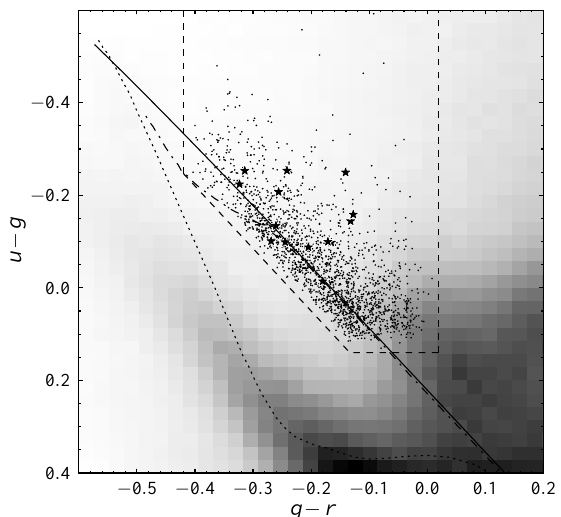
Figure 1: The greyscale represents the density of sources in the SDSS photometric database as a func- tion of colour, to a limiting magnitude g = 20 . 5 (dered- dened). The long period SDSS AM CVn binaries are in- dicated by star symbols. The solid line marks the black- body cooling track, the dotted and dot-dashed lines in- dicate model cooling sequences for DA and DB white dwarfs. The dashed lines indicate the colour cuts given by Roelofs et al. [29], and the dots indicate the candi- dates